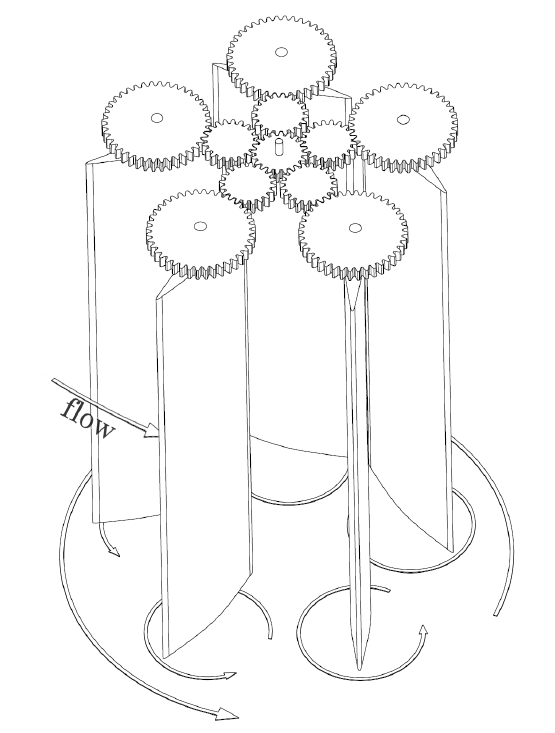
Figure 1. Sketch of the basic turbine components. The blades revolve around themselves while the machine is turning as well. The central gear is fixed in